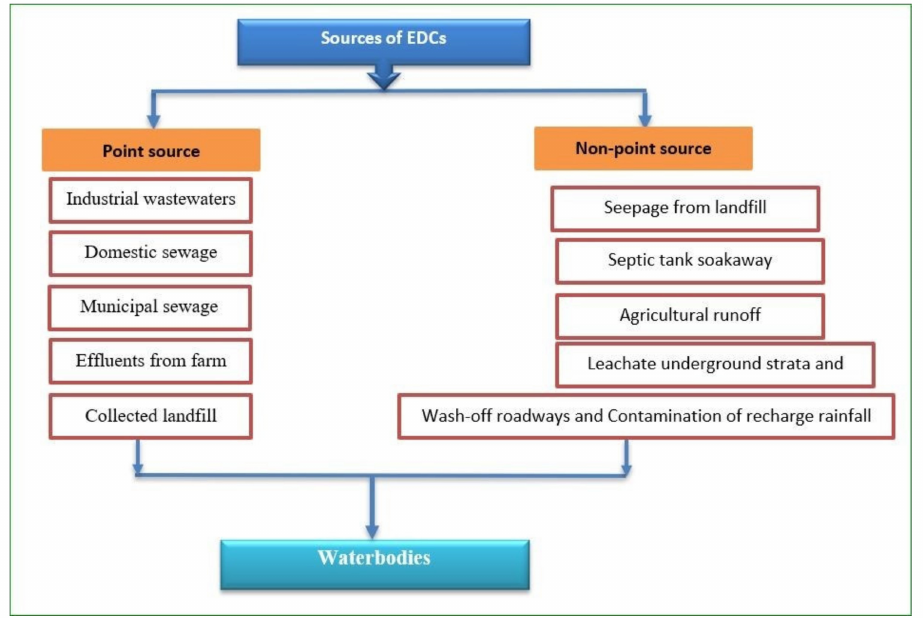
Figure 2. Representative sources of endocrine-disrupting compounds (EDCs) in the environmental matrices